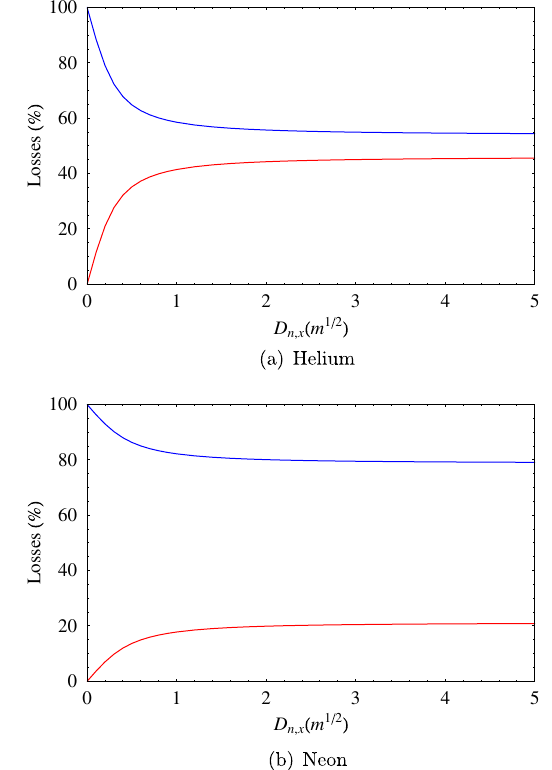
FIG. 47. Sum of the losses by collimation (red) and by decay (blue) versus the normalized dispersion at the primary collimator for a Gaussian